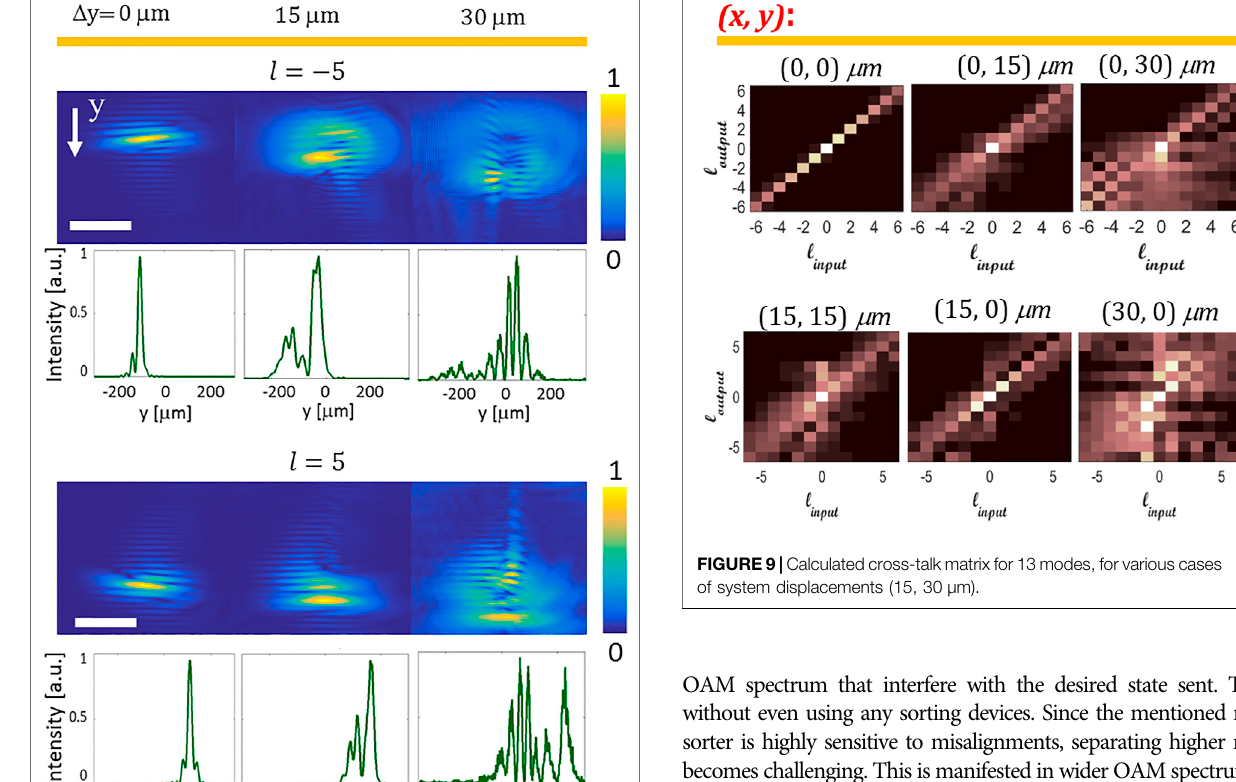
Figure 8 provides spectrum analysis of l (cid:2) ± 5 states, for Δ y (cid:2) 0 , 15 , 30 μ m displacements. The focused spots are accompanied